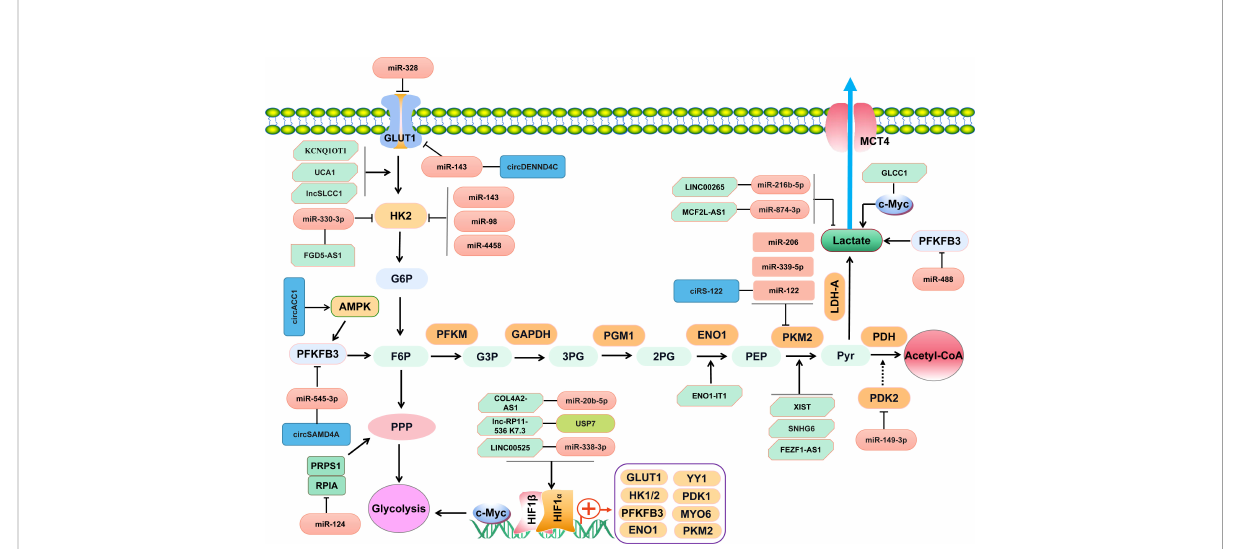
FIGURE 1 NcRNAs regulate key enzymes/transporters involved in glucose metabolism of CRC through complicated signaling